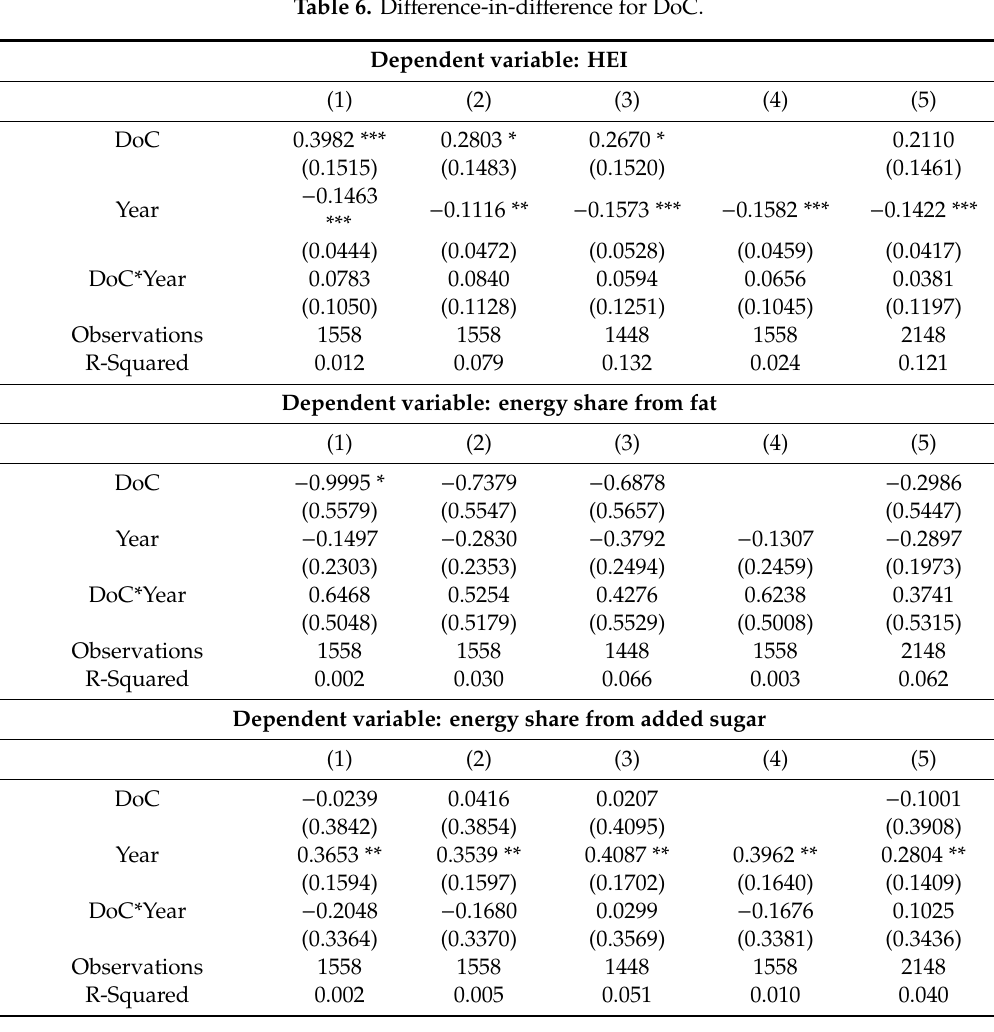
Table 6. Di ff erence-in-di ff erence for